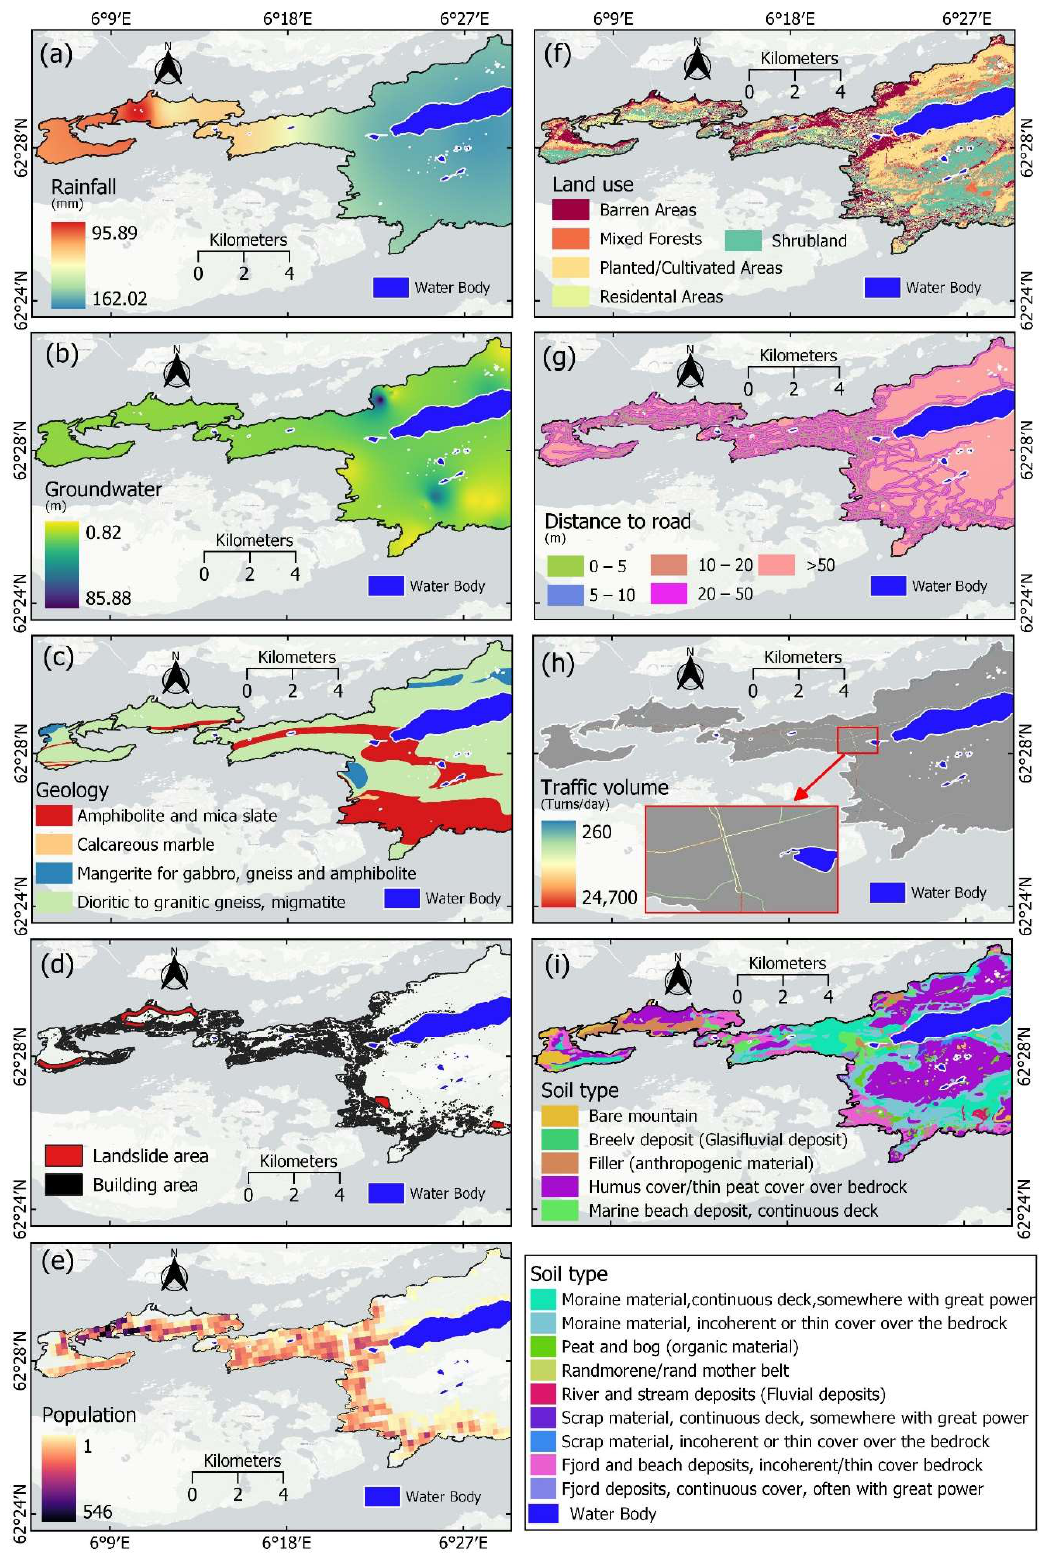
Figure A1. Maps of environmental factors: ( a ) Rainfall, ( b ) Groundwater, ( c ) Geology, ( d ) Land- slide and building area, ( e ) Population, ( f ) Land use, ( g ) Distance to road, ( h ) Traffic volume, and ( i ) Soil type.